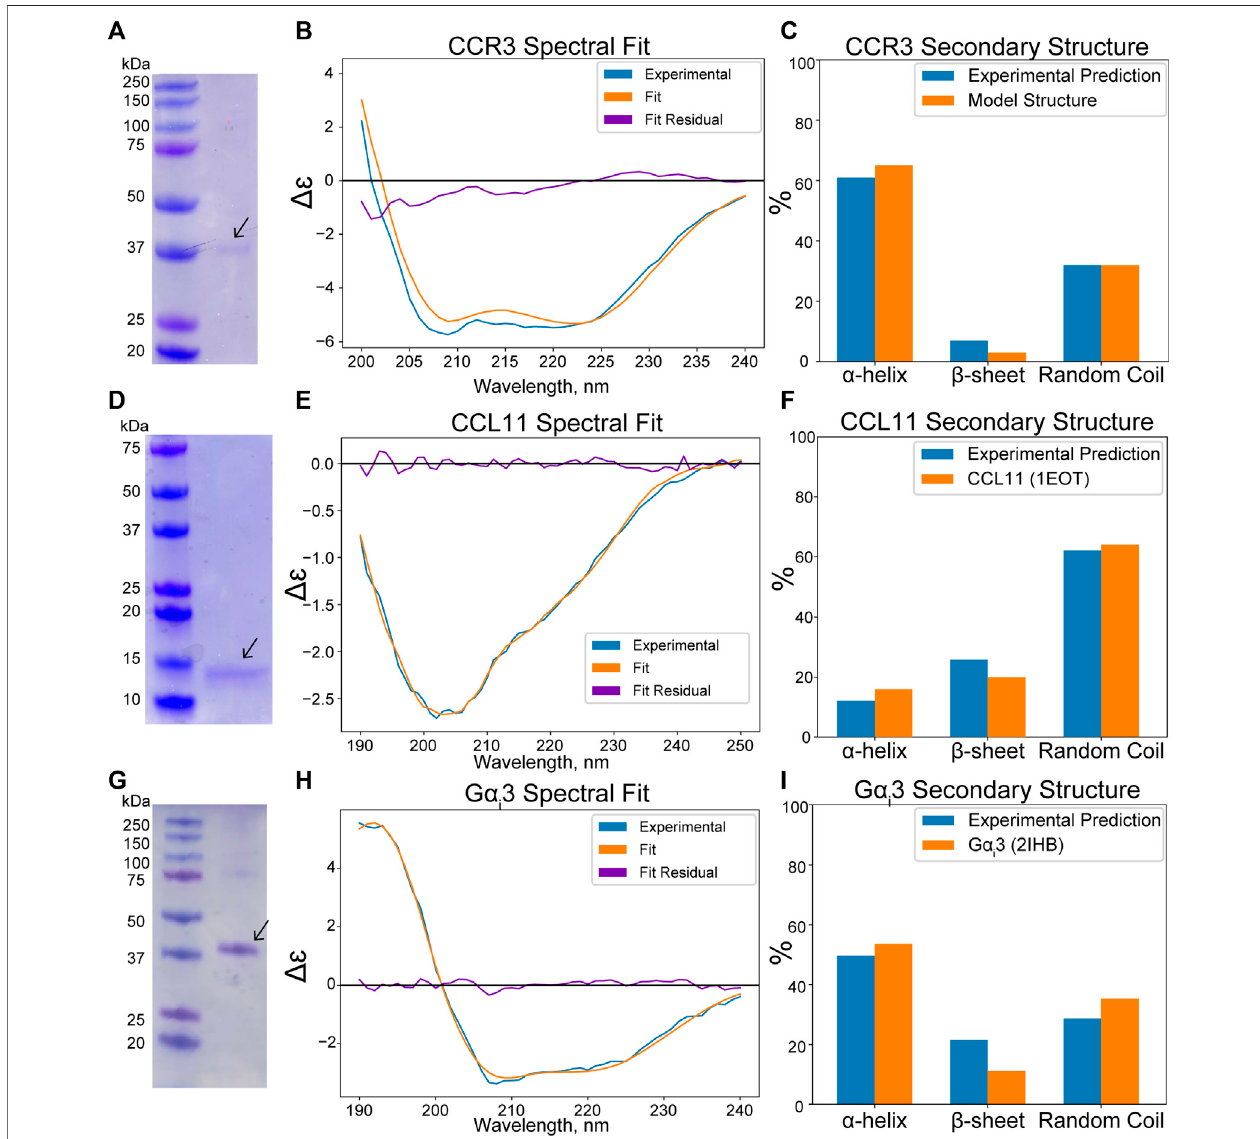
FIGURE4| (Wavelength,nm xaxislabelinpanelH)wascutoff. (A) SDS-PAGEanalysisofCCR3revealsa ∼ 37-kDaband,consistentwiththepredictedmolecular weight of42.4 kDa. (B) Experimental CDspectraofCCR3 (blue) compared totheDichroWeb (Whitmore and Wallace, 2004) experimental fi t(orange) and theresidual fi t (purple). (C) Quantitative assessment compared to the CCR3 model suggests a high degree of helical content. (D) SDS-PAGE analysis of CCL11 reveals an apparent molecular weight of ∼ 14 kDa, consistent with previous observations. (E) CD spectra of CCL11 (blue) compared to the fi t (orange) and the residual fi t (purple). The spectrum was fi t using Bestsel (Micsonai et al., 2015; Micsonai et al., 2018; Micsonai et al., 2021). (F) Bestsel-predicted percent secondary structure for the CCL11 construct compared to the NMR structure (PDB ID 1EOT) (Crump et al., 1998). (G) SDS-PAGE analysis of G α i 3 shows good agreement with the predicted construct molecular weight of 42.7 kDa. (H) CD spectra of G α i 3 (blue) compared to the DichroWeb experimental fi t (orange) and the residual fi t (purple). (I) Comparison of the experimentally predicted % secondary structure to that found in the crystal structure (PDB ID 2IHB) (Soundararajan et al.,